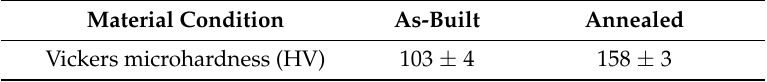
Figure 5. ( a,b ) SEM images of as-built AlMgSc alloy. Table 2. Vickers microhardness in as-built and annealed condition for AlMgSc alloy.